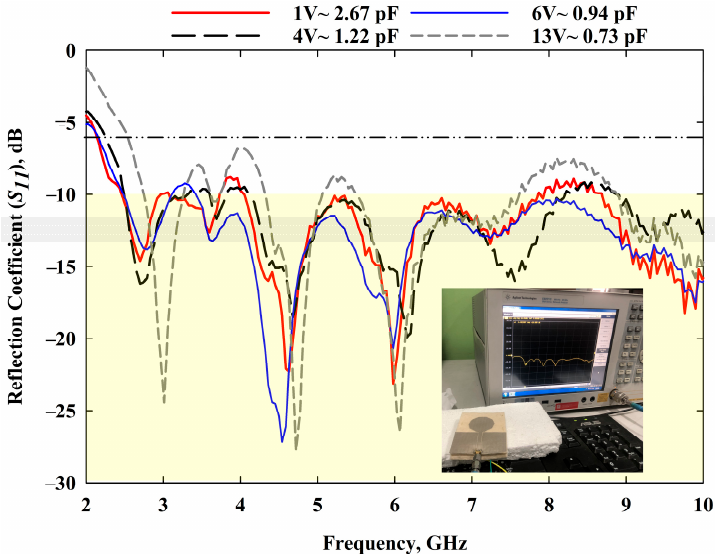
Figure 9. Measured S 11 results.